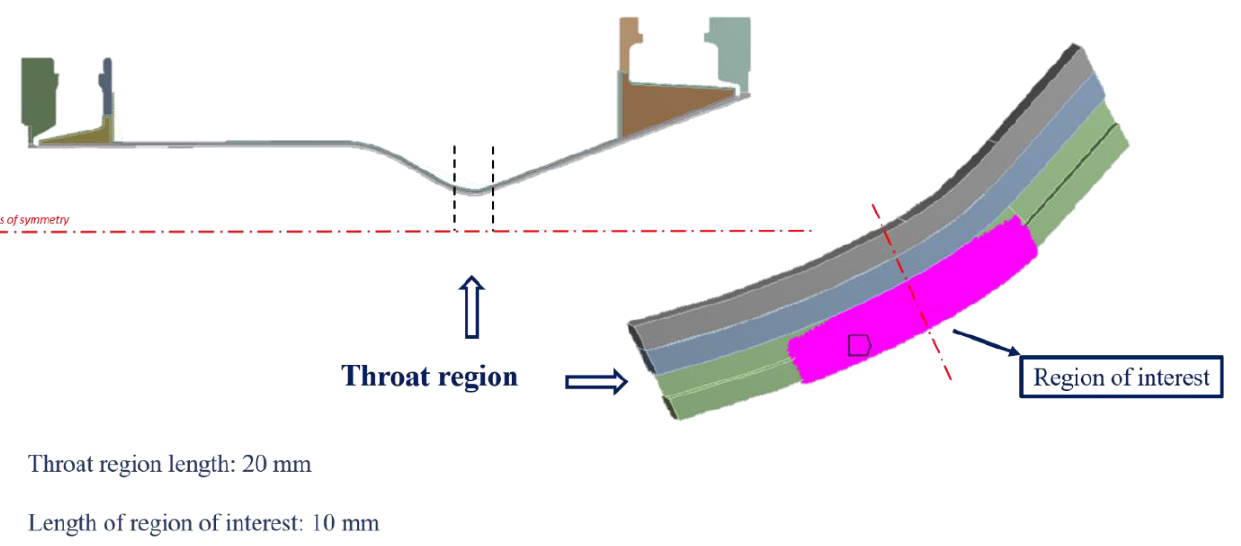
Figure 4. Thrust chamber geometry.